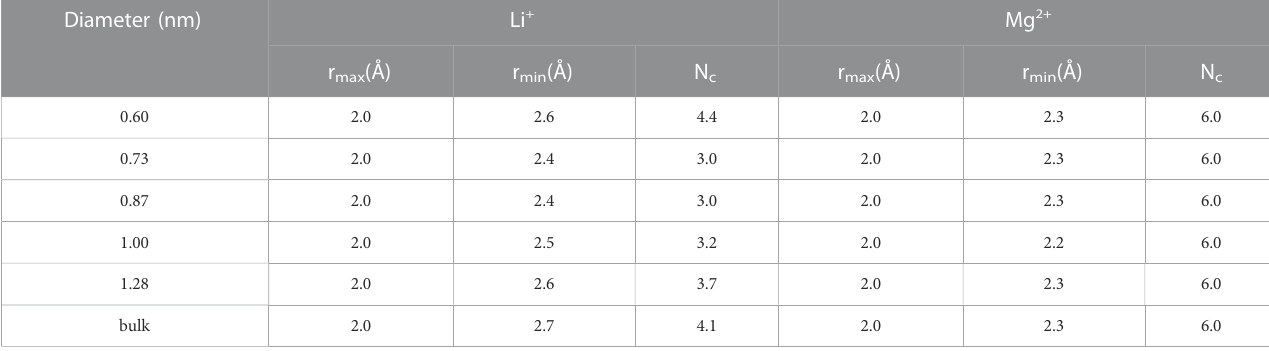
TABLE 1 Position of the fi rst maximum (r max ) and fi rst minimum (r min ) of the ion-oxygen RDFs for Li + and Mg 2+ and the coordination number (Nc) of their fi rst coordination shells. Diameter